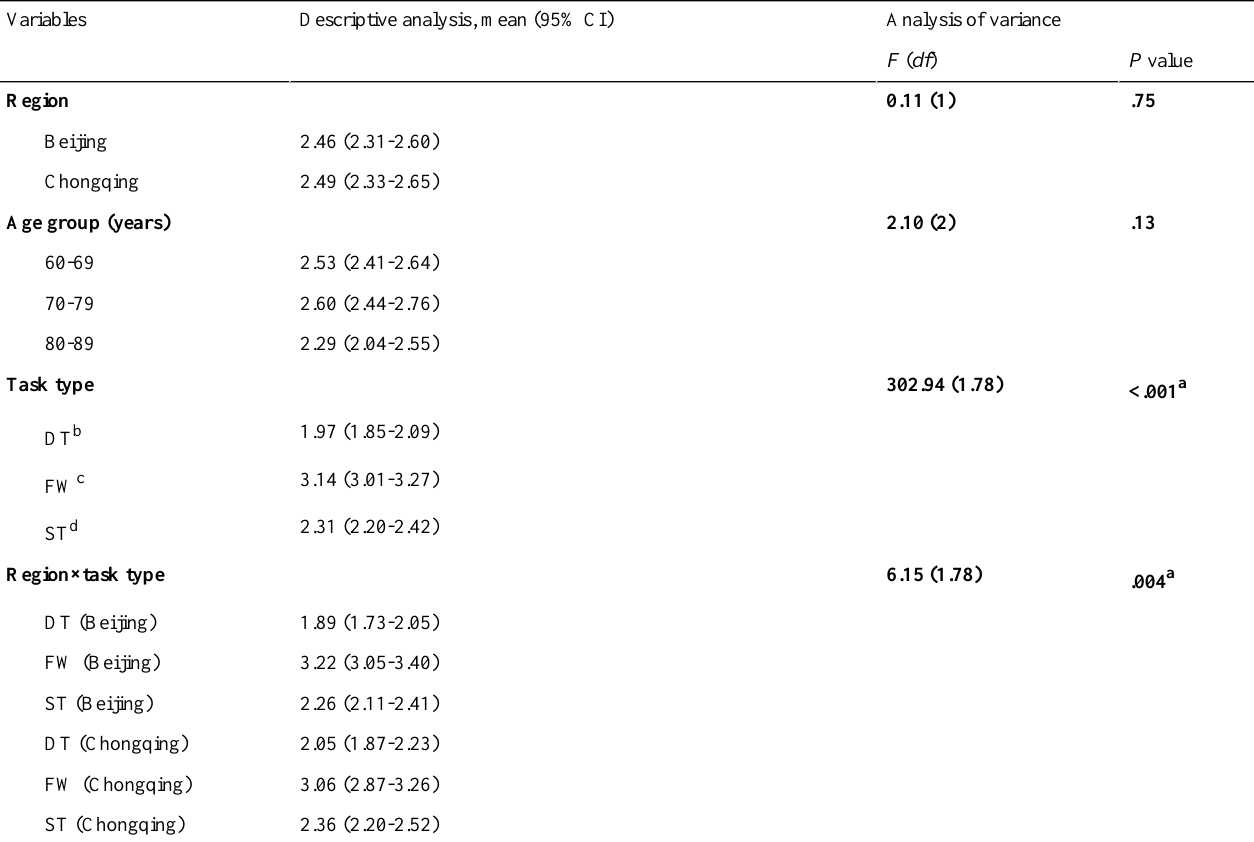
Table 3. Statistics for root mean